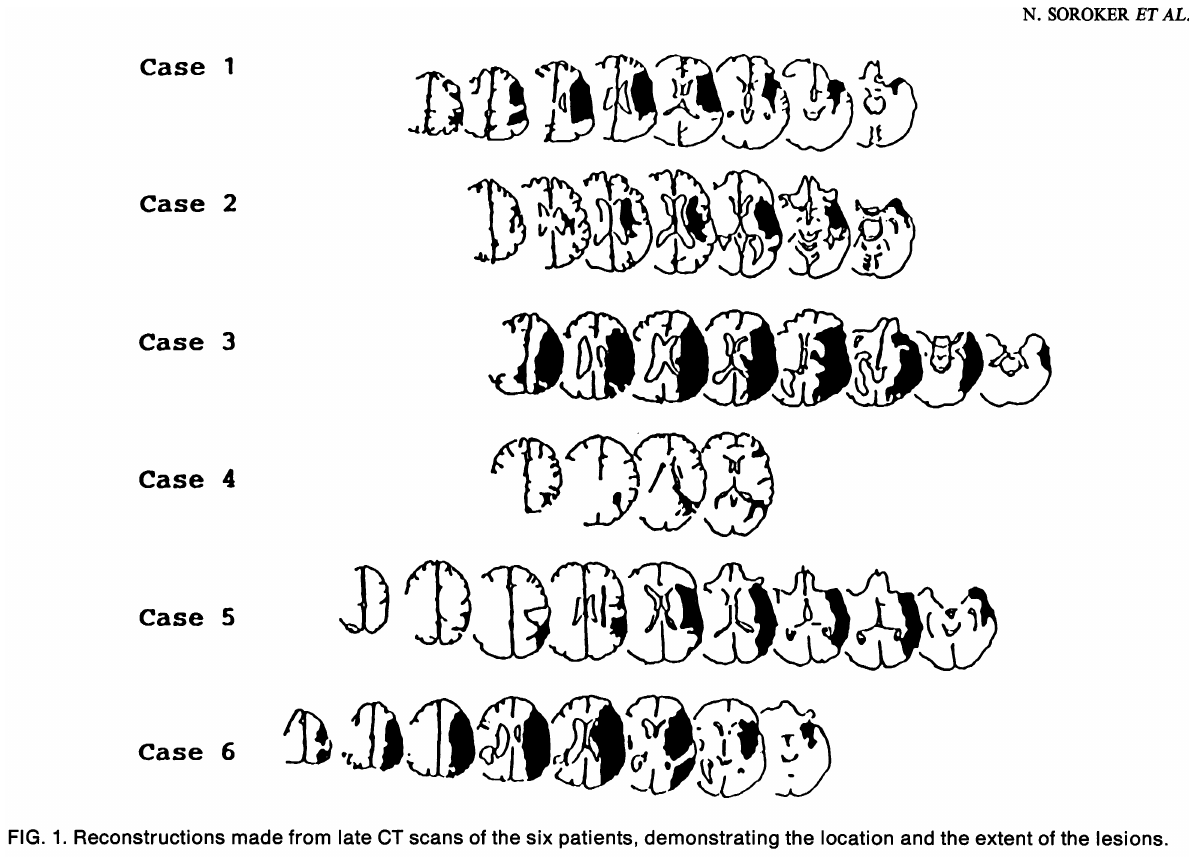
FIG. 1. Reconstructions made from late CT scans of the six patients, demonstrating the location and the extent of the lesions.